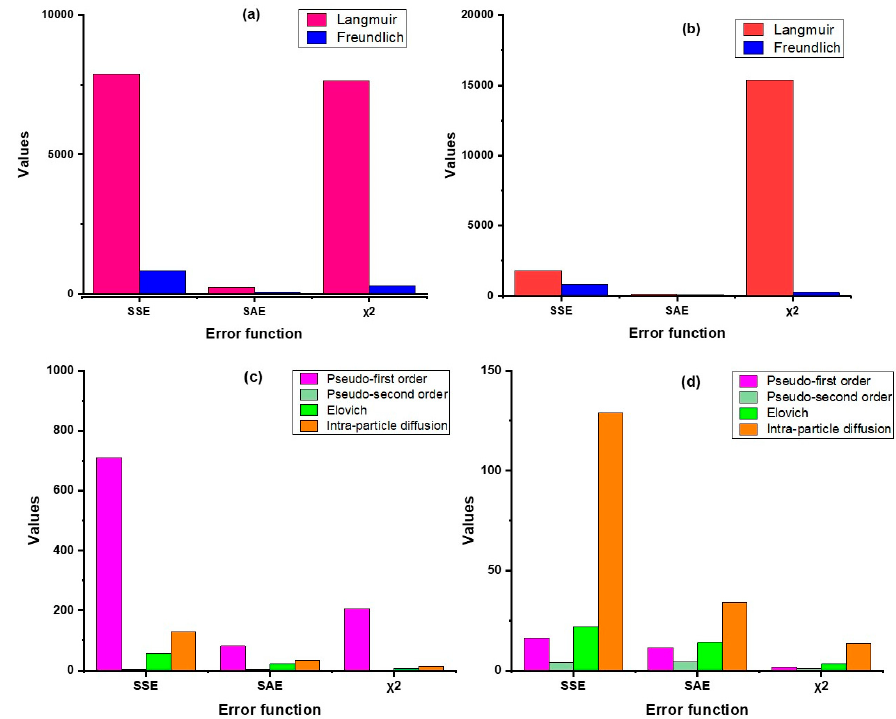
Figure 3. Error analysis of isotherm models (linear ( a ) and non-linear ( b )) and kinetic models (linear ( c ) and non-linear ( d )) for nZVI-Bare. SSE, error sum of squares; SAE, sum of absolute error; χ 2 , chi-square; AICc, corrected Akaike Information Criterion.